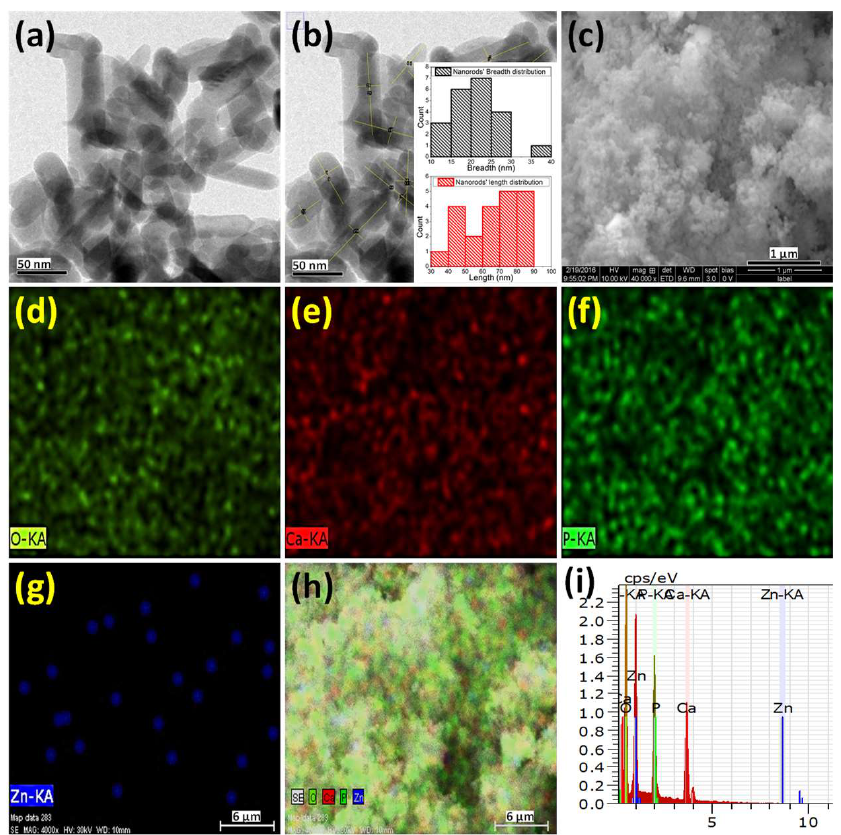
Figure 2. ( a ) TEM ( b ) TEM image with statistical size distribution of the nanorods ( c ) SEM ( d – h ) elemental mapping images, and ( i ) EDS spectrum of the prepared HAp-ZnO composite.